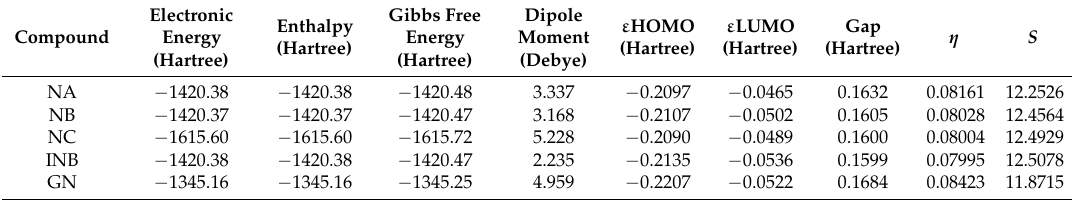
Table 5. Results of quantum chemical calculations and thermodynamic properties of the compounds.